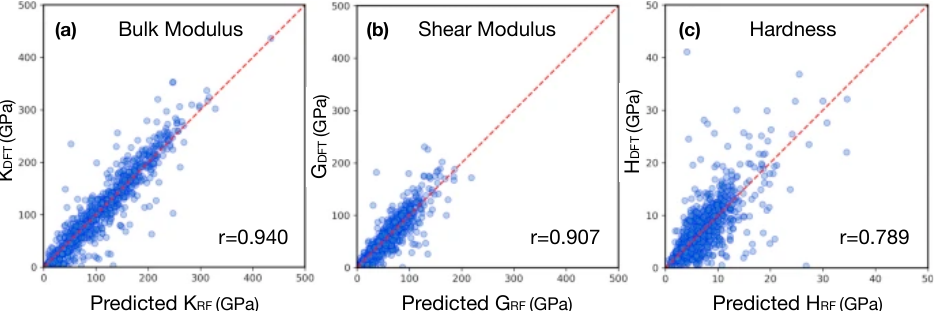
Figure 12. ML and Hardness in multi-component alloys. The Pearson correlation coefficient (r) is utilized as a metric for ( a ) bulk modulus (K), ( b ) shear modulus (G), and ( c ) hardness (H) for 10,421 alloy samples acquired from the Materials Project database [32]. The machine learning models are trained to predict, K, and G, based on density functional theory (DFT) calculations. (Reproduced from [43], based on Creative Commons Attribution 4.0